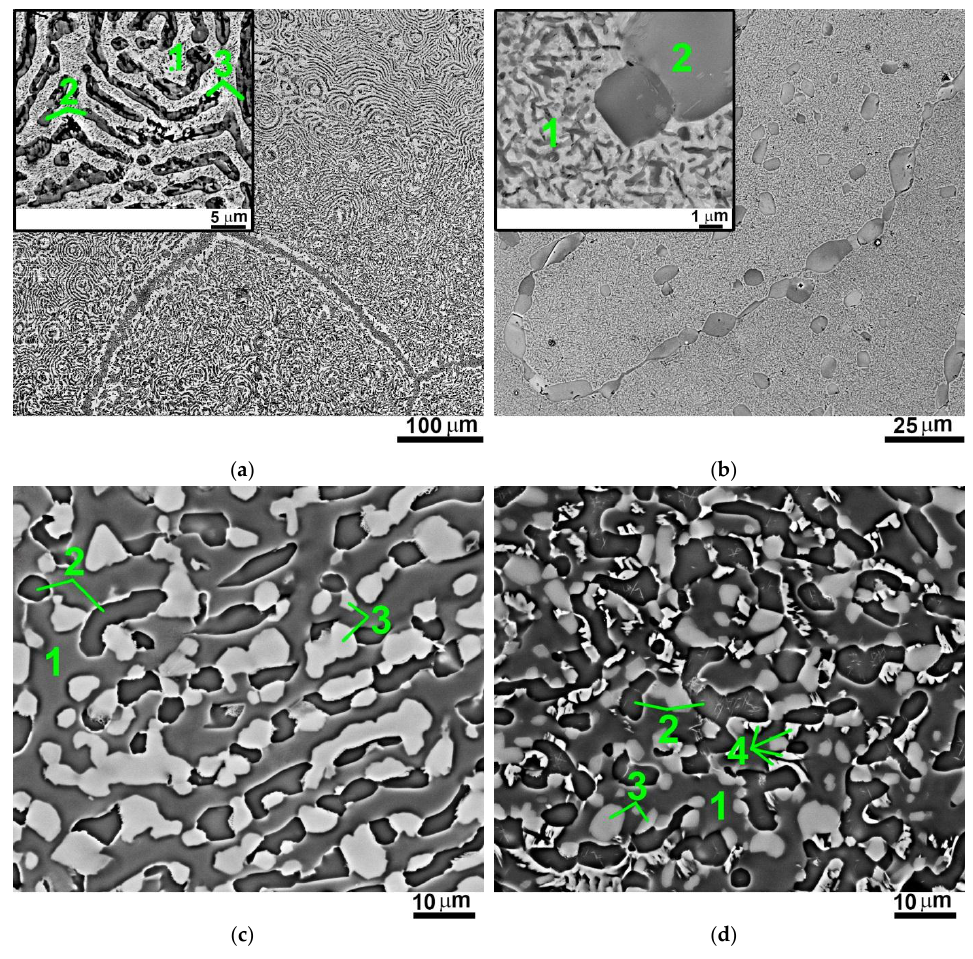
Figure 6. SEM-BSE images of the microstructures of the Al x NbTiVZr ( x = 0 ( a ); 0.5 ( b ); 1 ( c ); 1.5 ( d )) alloys after annealing at 800 °С for 100 h. Chemical compositions and volume fractions of the numbered constituents are given in Table 3. Table 3. Chemical compositions, volume fractions and dimensions of the constituents of the Al x NbTiVZr ( x = 0; 0.5; 1; 1.5) alloys after annealing at 800 °С for 100 h. Typical regions used for analysis are shown in Figure 6.